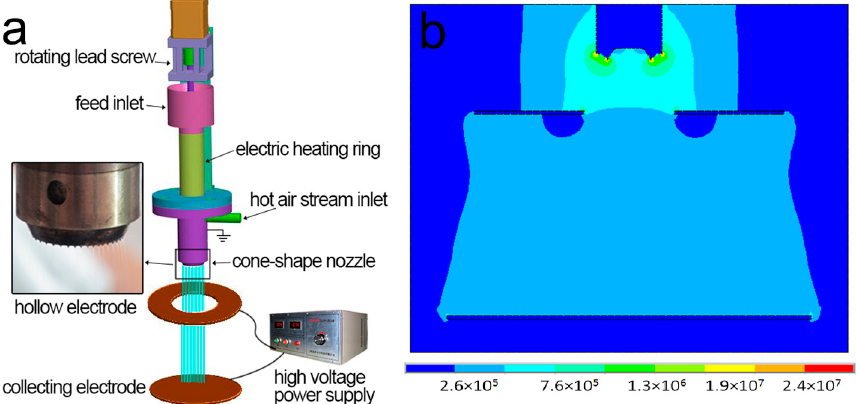
Figure 1. Schematic diagram ( a ) and electric simulation ( b ) of melt differential electrospinning device.